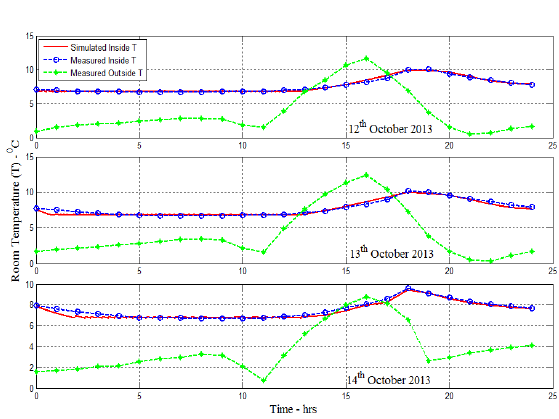
Figure 12: Inside and outside temperature variations